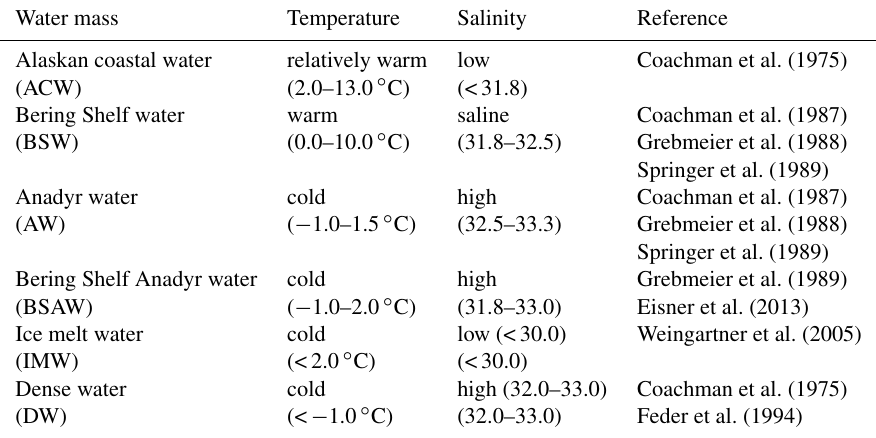
Table 1. Water mass properties in the northern Bering and Chukchi seas.